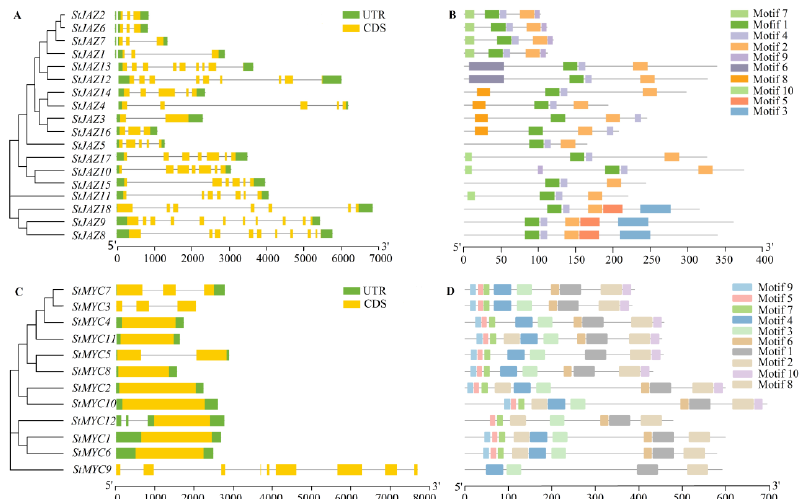
Figure 3. StJAZ and StMYC genes Structure and motif. ( A ) The gene structure analysis of StJAZ ; ( B ) The motif composition in potato JAZ proteins; ( C ) The exon–intron structure of StMYC ; ( D ) The motif composition of StMYC proteins. UTRs are represented by green rectangles, exons by yellow rectangles, and introns by black lines. Overall, in the StJAZ and StMYC families, members of the same subfamily have com- parable intron/exon patterns and motif components. For the StJAZ family, different sub- family members are different in exons, motif type, and number. For the StMYC family, members of the different subfamilies have similar motifs and variety, but the exon/intron structure was slightly different. The results show that the JAZ gene family and MYC gene family may have undergone different evolutionary selection events.